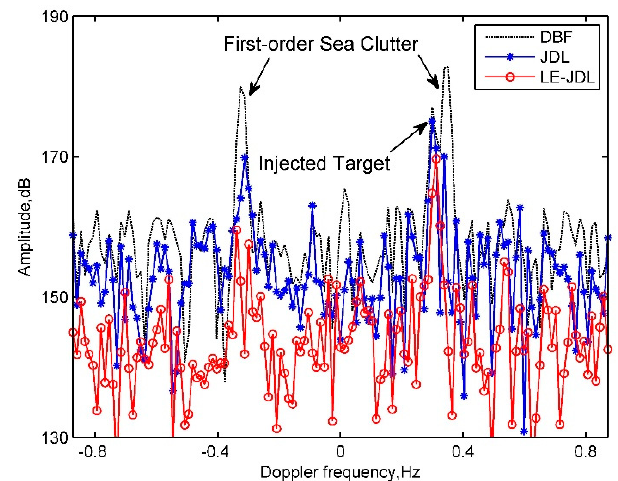
Figure 7. Doppler profile result of DBF method, conventional joint domain localized (JDL) method and proposed LE-JDL method with simulated target.